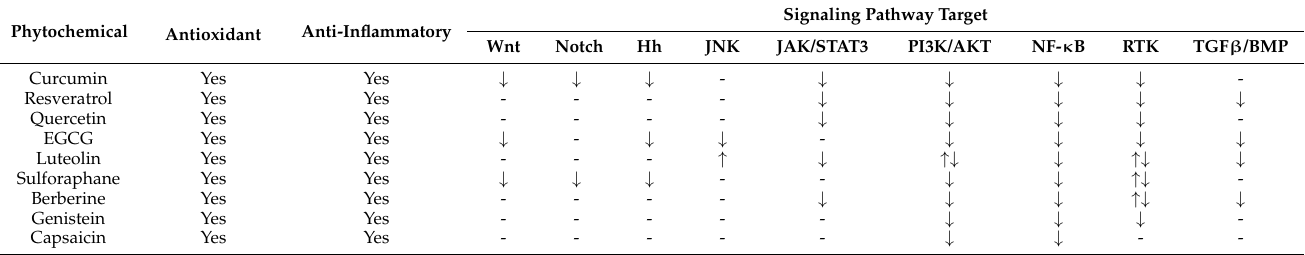
Table 1. Summary of the activity of listed phytochemical compounds on targeting signaling pathways. Phytochemical